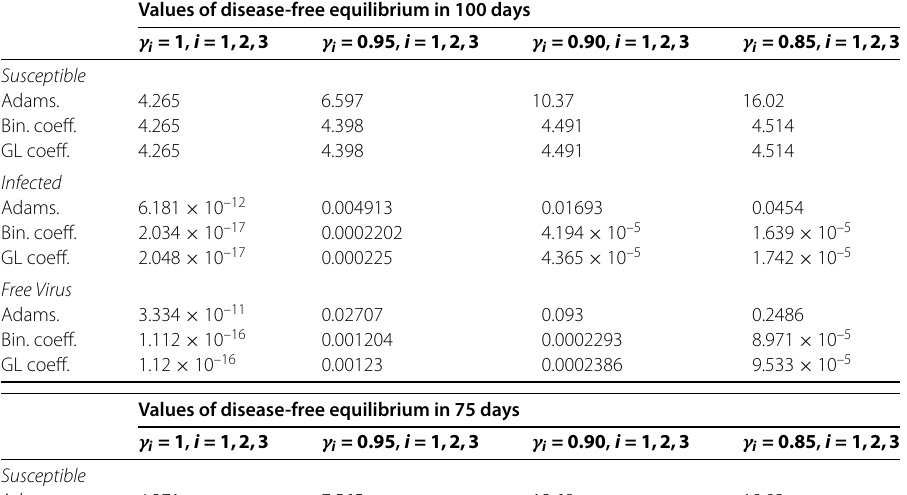
Table 2 Values of disease-free equilibrium at different time periods Values of disease-free equilibrium in 100 days γ i = 1 , i = 1,2,3 γ i = 0.95 , i = 1,2,3 γ i = 0.90 , i = 1,2,3 γ i = 0.85 , i = 1,2,3 Susceptible